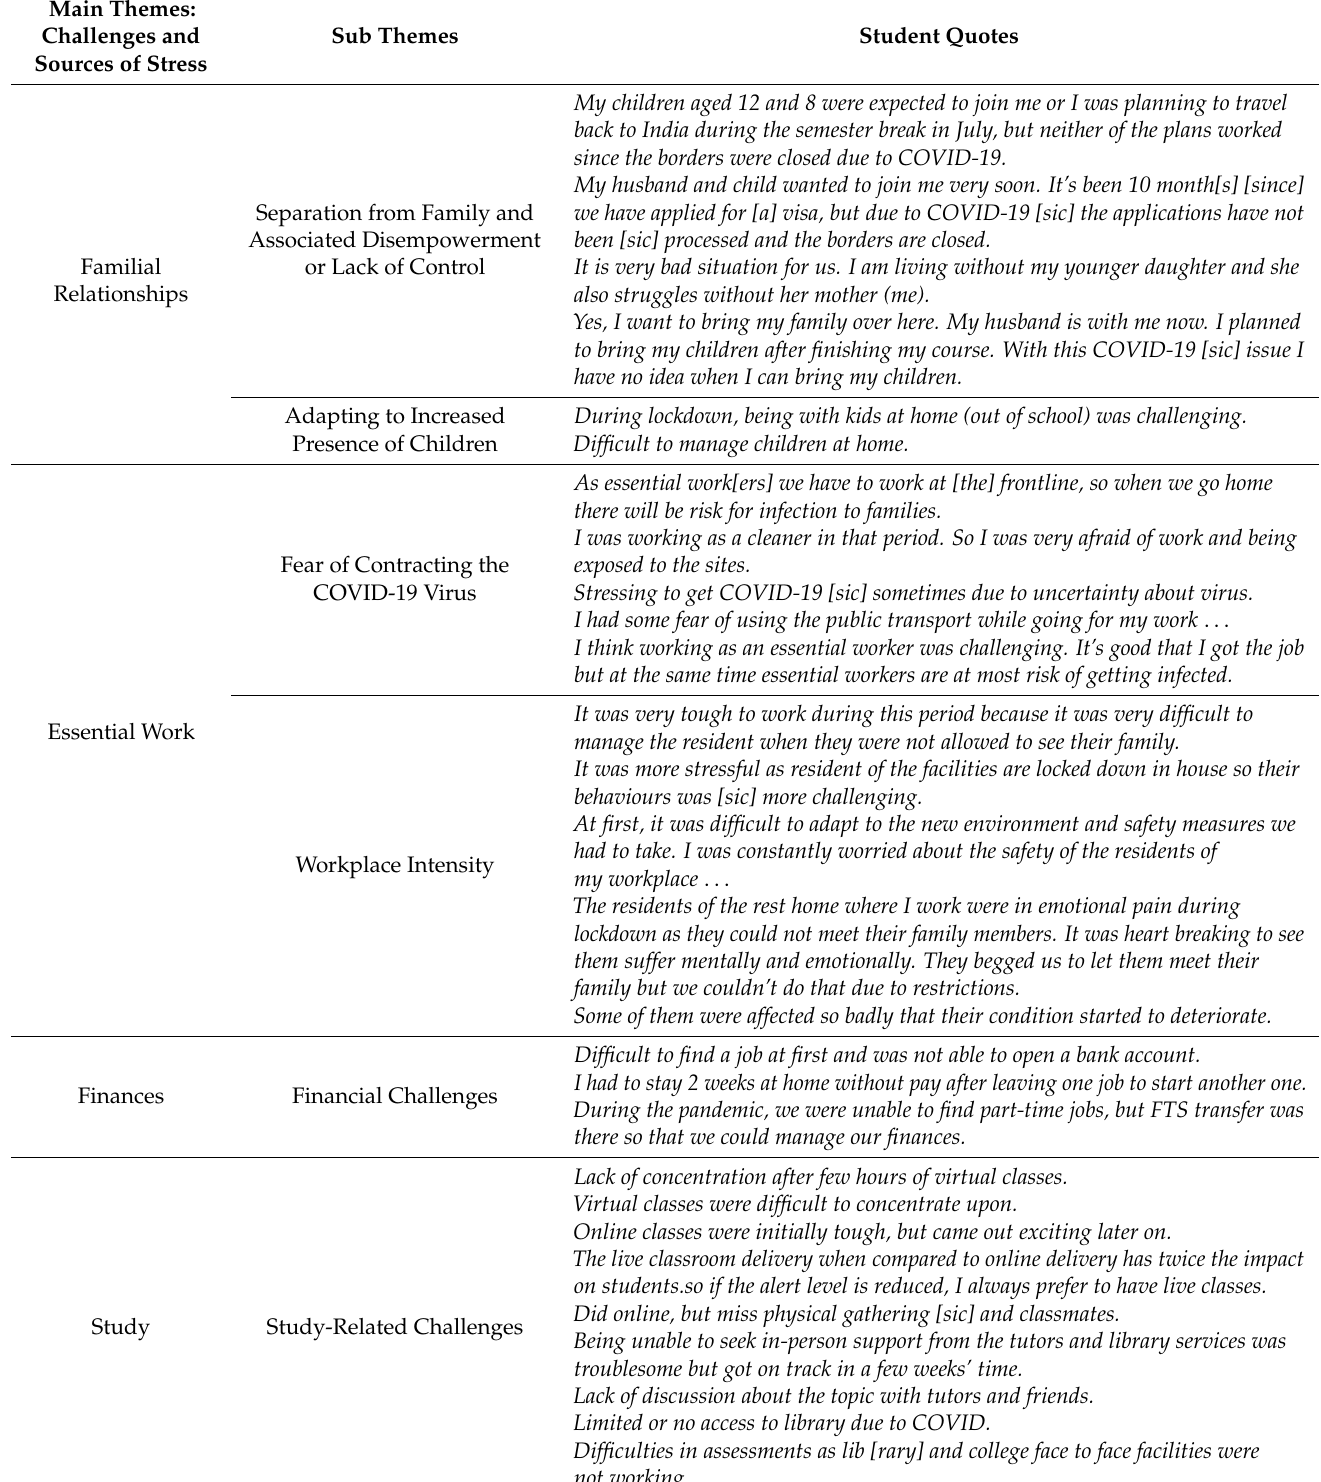
Table 3. Qualitative data showing the main themes, subthemes, and quotes as identified from the challenges faced by students and their sources of stress over the COVID-19 lockdown in New